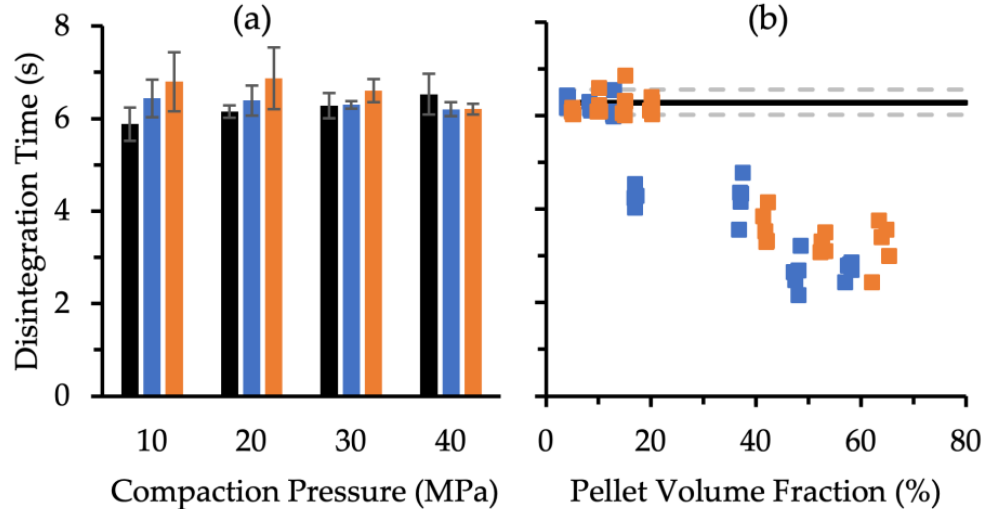
Figure 5. Disintegration times of control tablets ( (cid:4) ) and MUPS tablets prepared with MCC ( (cid:4) ) and XPVP ( (cid:4) ) pellets at various ( a ) compaction pressures, where the error bars represent the standard deviation ( n = 5) and ( b ) pellet volume fractions, where each symbol represents an individual sample, the solid horizontal line represents the disintegration time of the control tablets, and the bracketing represents the standard deviation lines (dashed).